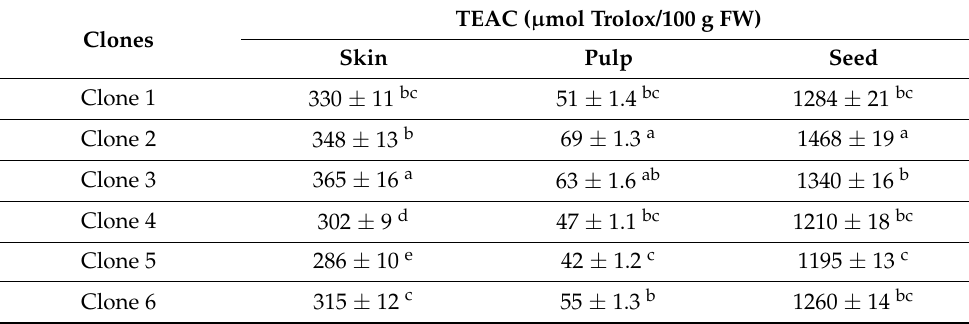
Table 5. TEAC assay results of ‘Köhnü’ grape clones. TEAC ( µ mol Trolox/100 g FW) Clones Skin Pulp Seed Clone 1 330 ± 11 bc 51 ± 1.4